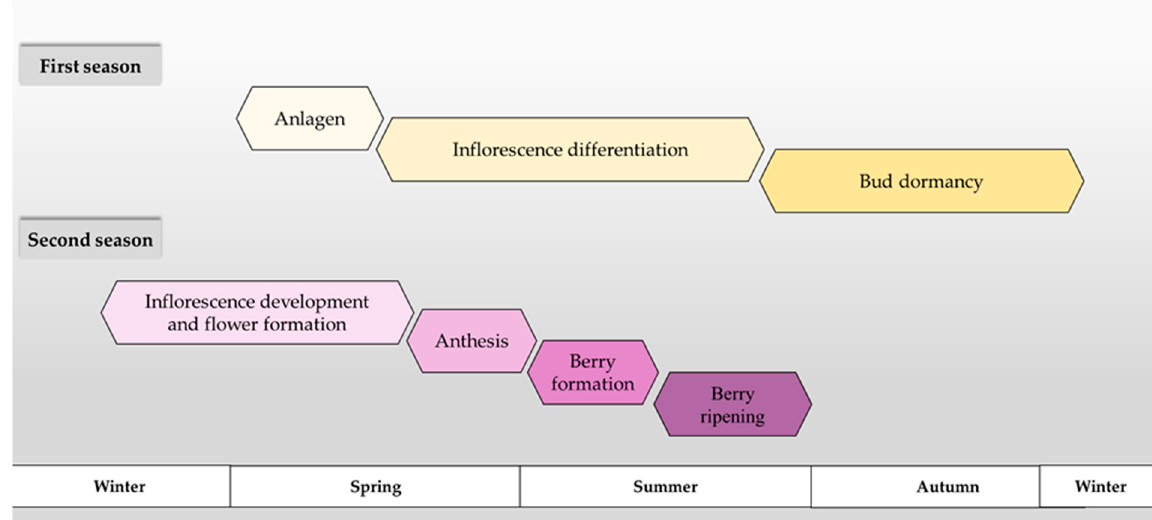
Figure 1. Grapevine reproductive cycle showing the sequence of cluster formation events over two growing